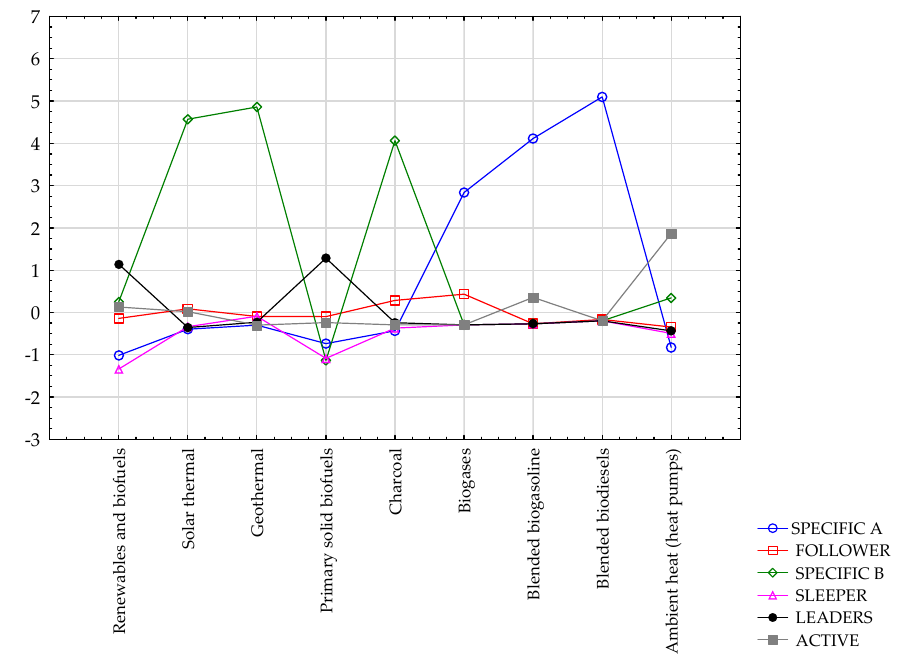
Figure 6. Mean values of energy consumption from renewable energy sources for individual clusters (results of the non ‐ hierarchical grouping of similarities between the EU countries in final energy consumption from renewable energy sources in households’ sector in 2019 using the k ‐ mean’s method). Source: own elaboration based on data from [7].